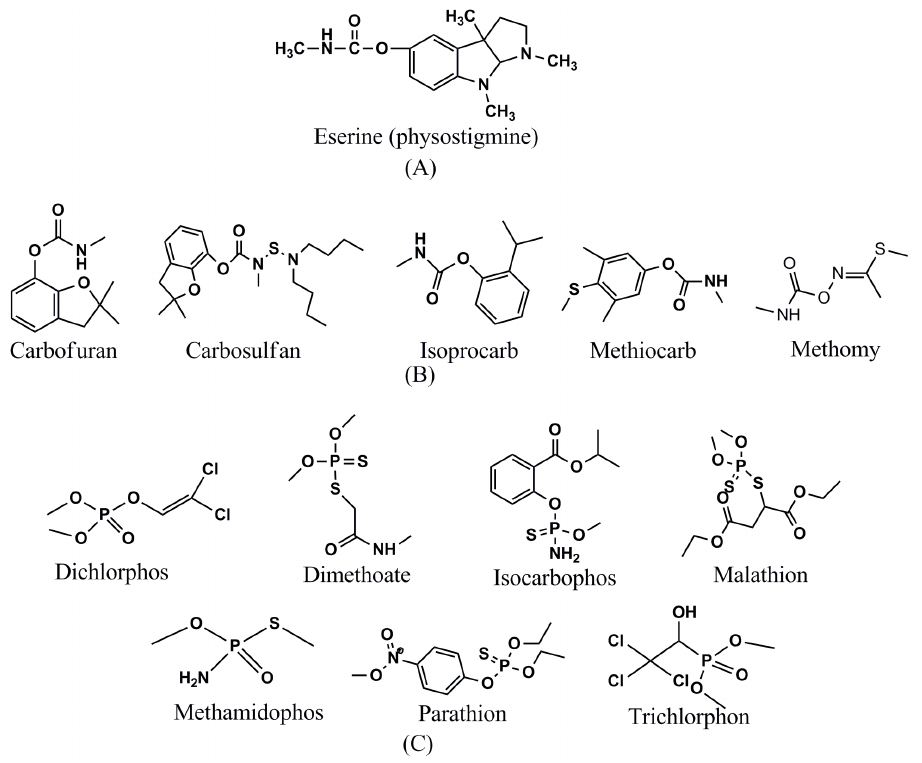
Figure 1. The chemical structures of the different compounds tested. (A) structure of the natural inhibitor of AChE, (B) structures of the CB pesticides, (C) structures of the OP pesticides.